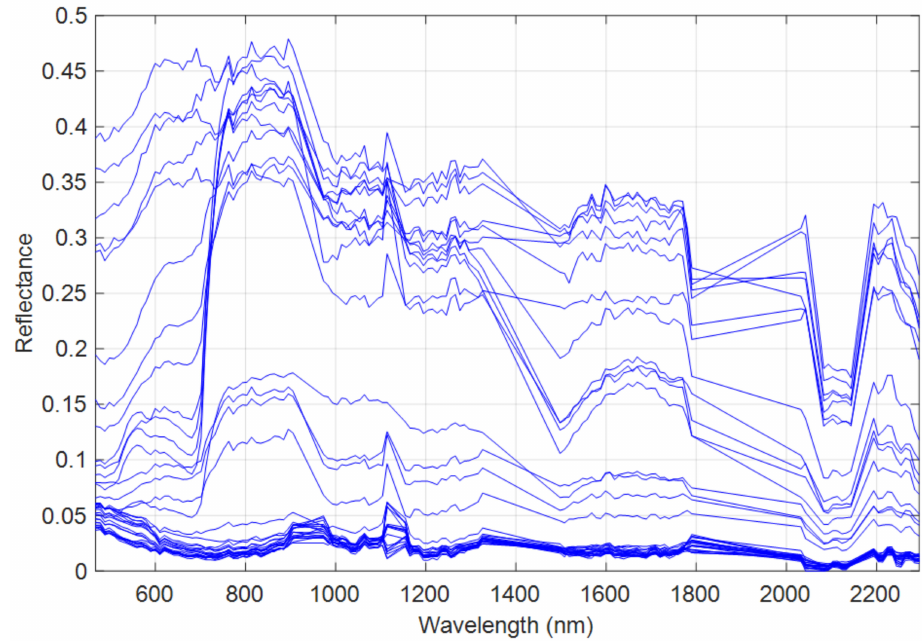
Figure 7. Spectral library extracted from the real data by AEEB.